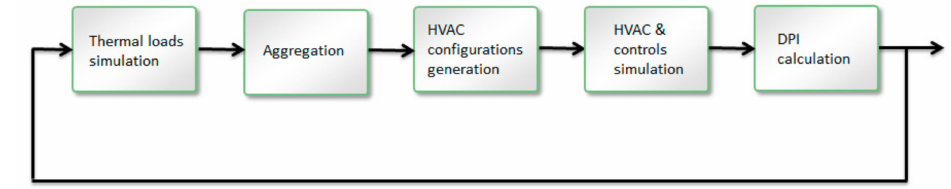
Figure 5. Scenario generation and simulation process followed by the decision-support tool.